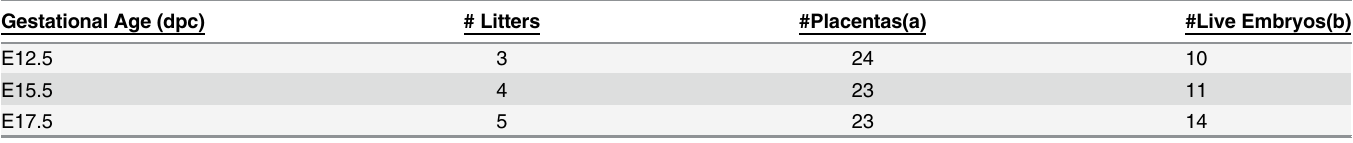
Table 1. Viability of mid-gestation DNMT1o-deficient conceptuses. Viability of litters collected at mid-gestation in this